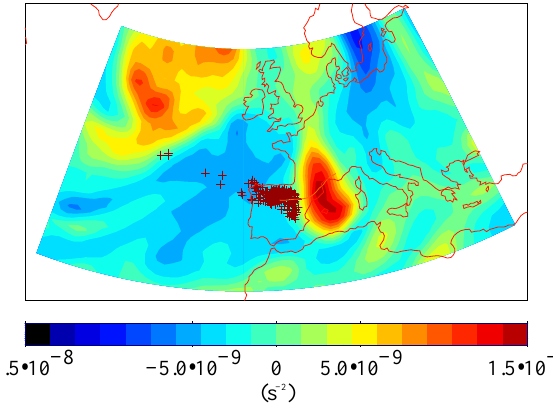
Fig. 10. Residual of the nonlinear balance equation at 190 hPa, on 2 September 1997 at 14:00 UTC. The intersection of the rays with the 190 hPa surface and the observed ray are shown as in Fig. 9.